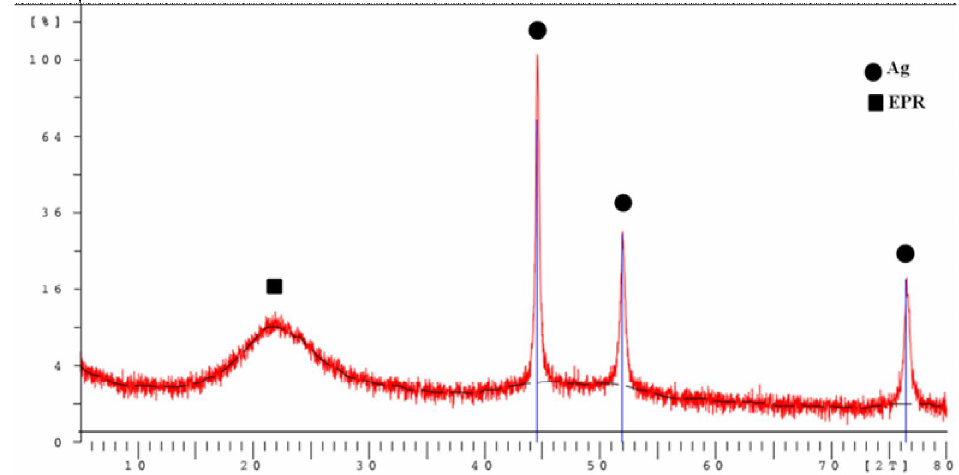
Fig. 6. The XRD pattern of AgNP@EPR